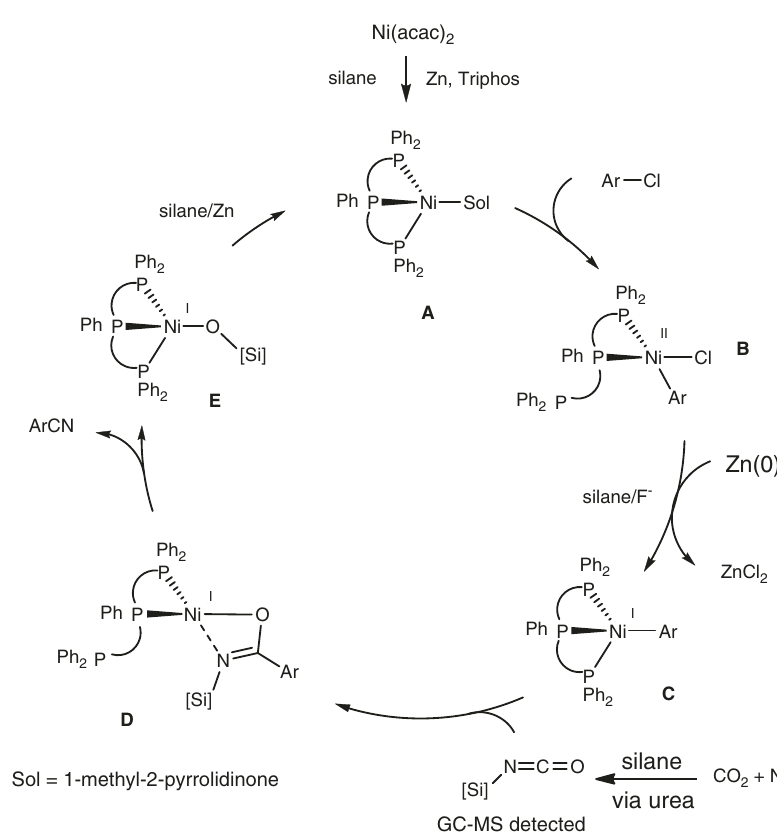
Fig. 8 Plausible reaction mechanism. Ni/phosphine-catalyzed reductive cyanation of organic chlorides using CO 2 /NH 3